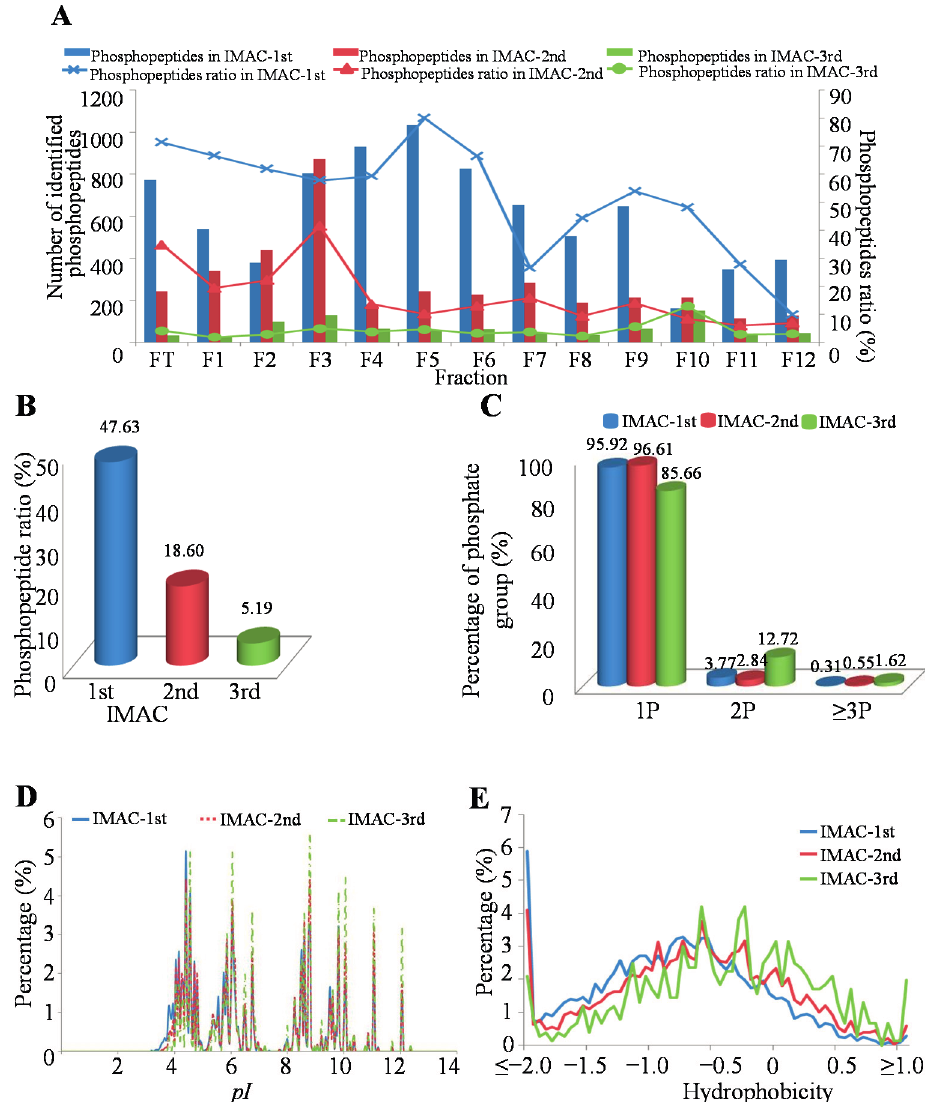
Figure 2. Characteristics of the identified unique phosphopeptides in different HPLC fractions and IMAC steps. ( A ) Distribution of identified unique phosphopeptides in different HPLC fractions; ( B ) Distribution of identified unique phosphopeptides in different IMAC steps; ( C ) Distribution of phosphorylated peptides based on their phosphorylation sites (p-sites) in different IMAC steps; ( D ) The pI value distribution of the identified phosphopeptides in different IMAC steps; ( E ) The hydrophobicity distribution of the identified phosphopeptides in different IMAC